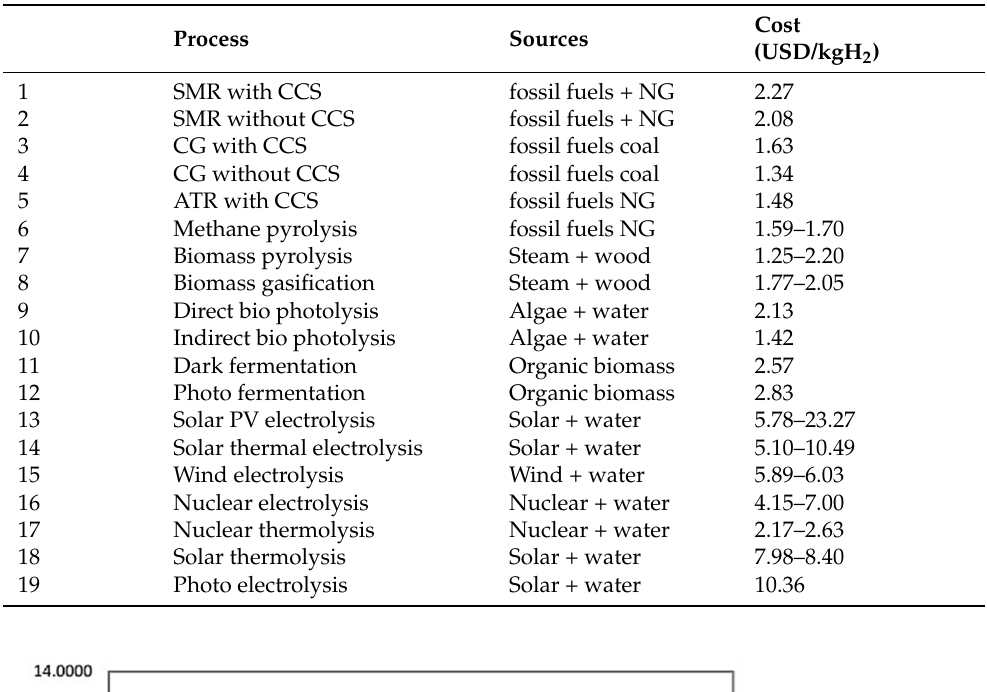
Table 6. Various hydrogen production processes and their sources (feedstocks and energy) and cost per kg of hydrogen. Reprinted with permission [28,57].